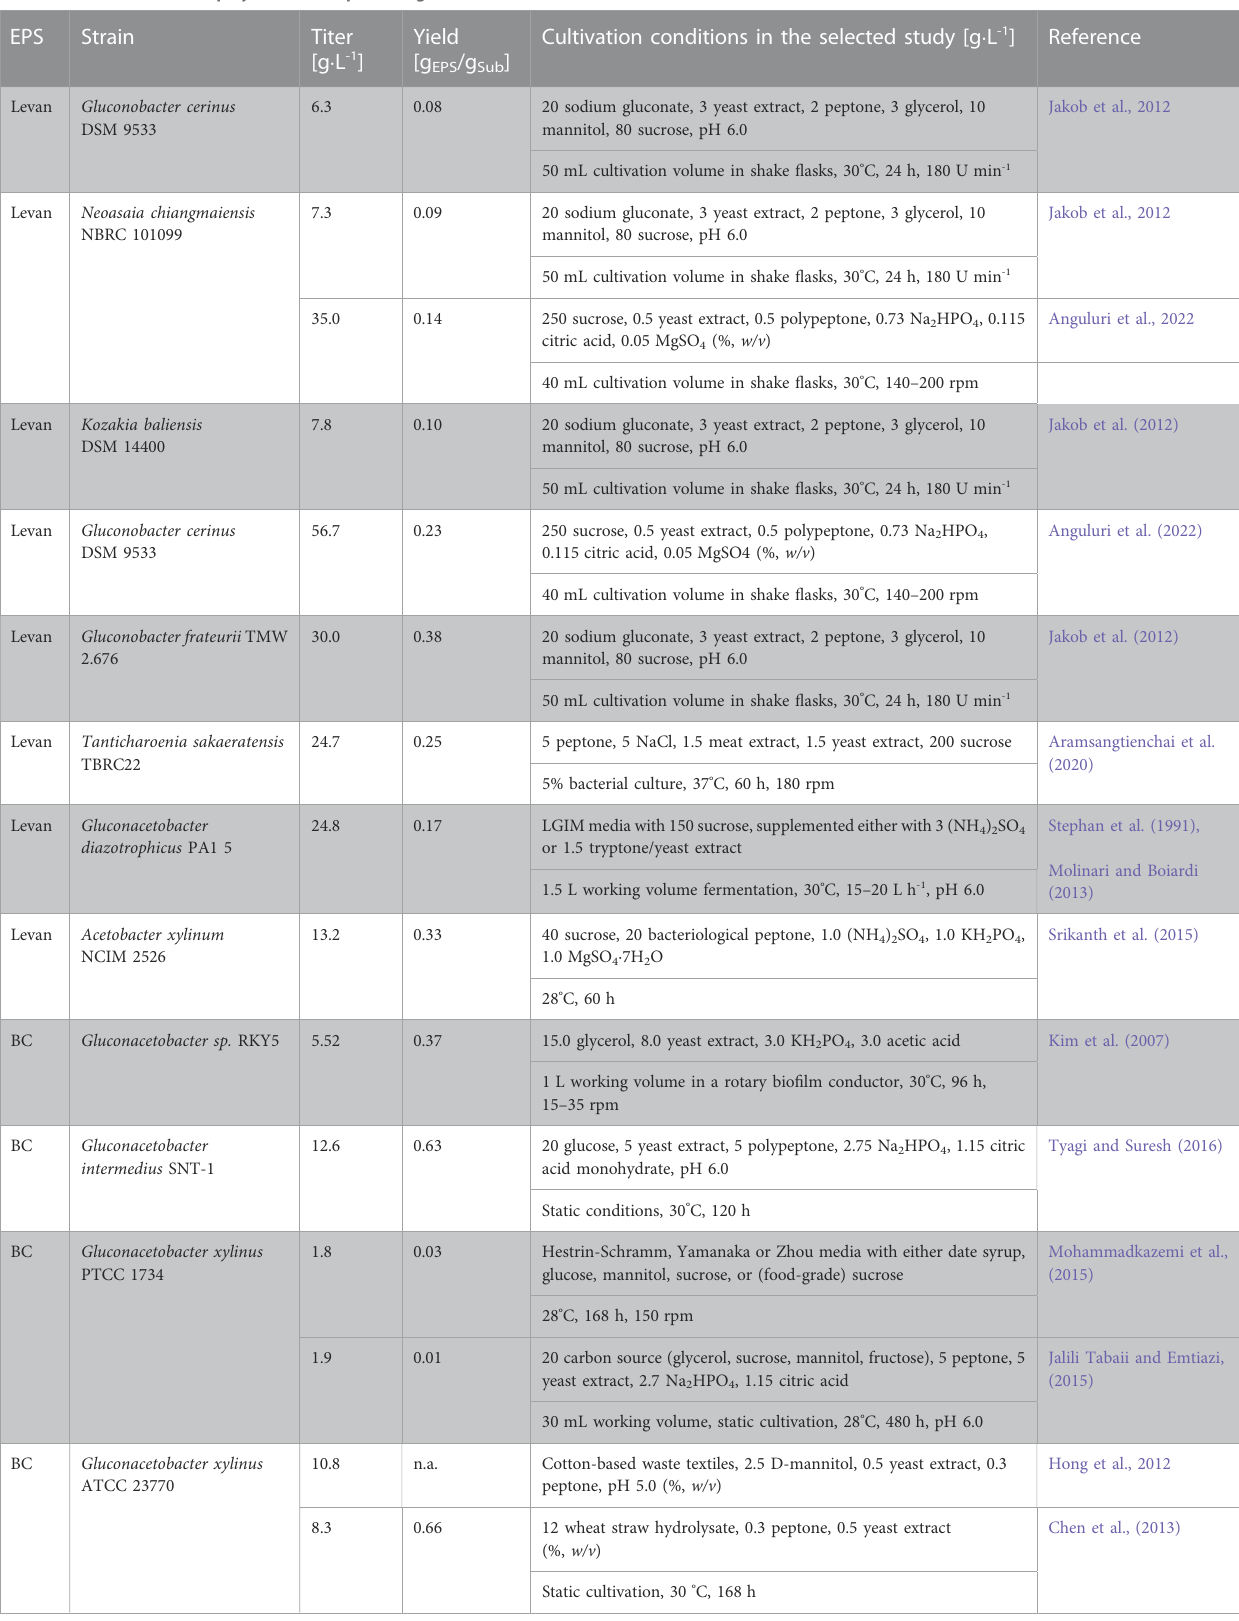
TABLE 1 Overview of homopolysaccharides producing Acetobacteraceae . EPS